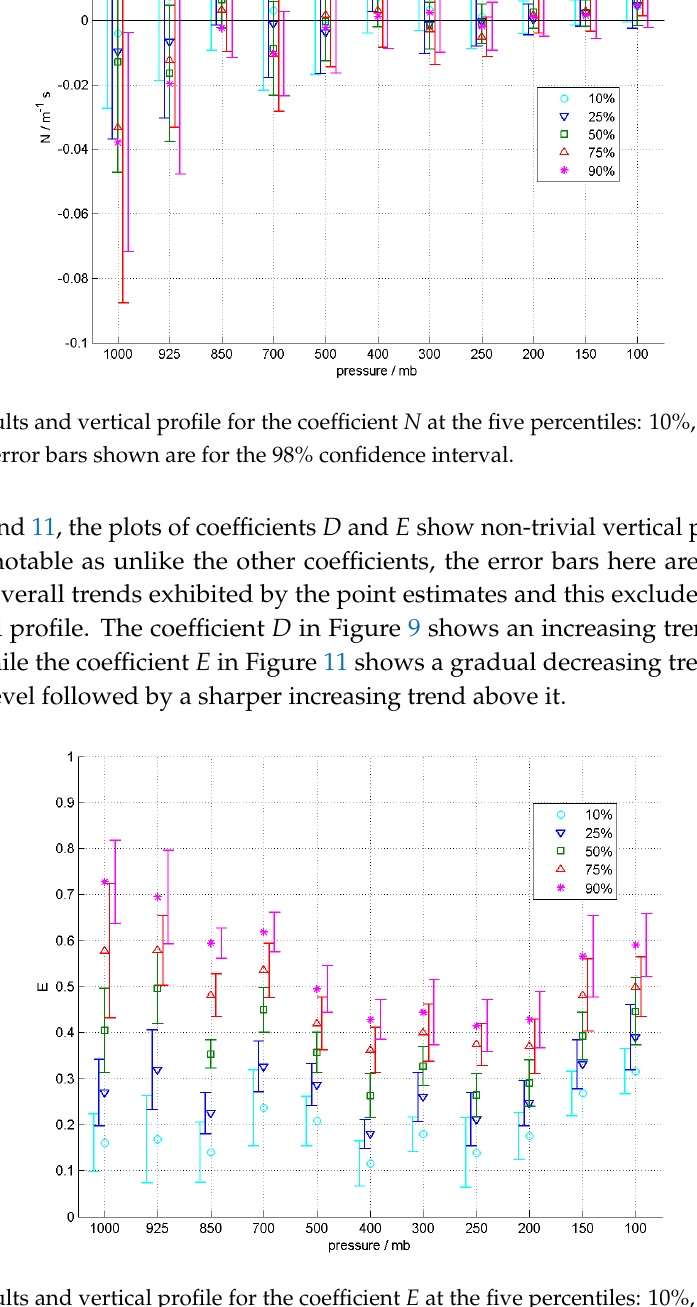
Figure 9. Results and vertical profile for the coefficient D at the five percentiles: 10%, 25%, 50%, 75%, and 90%. The error bars shown are for the 98% confidence interval.